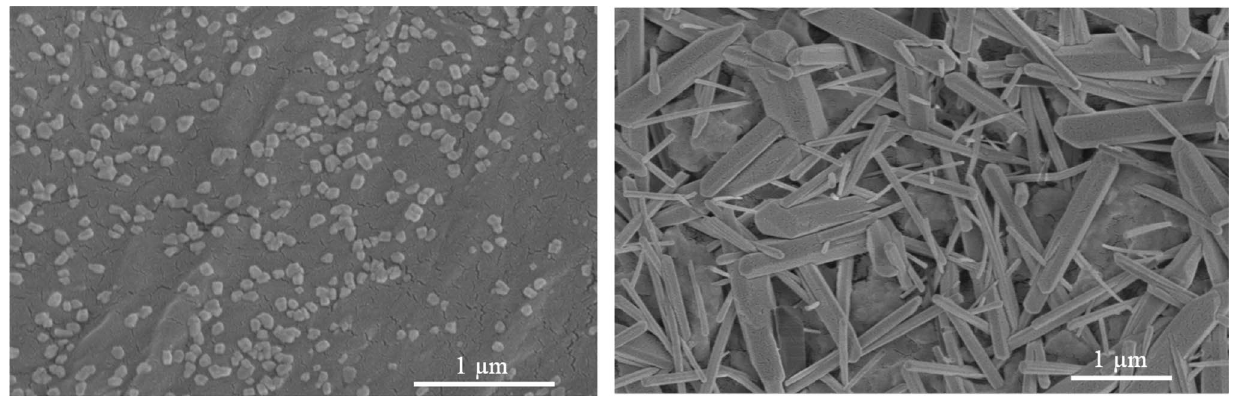
Fig. 5 SEM images of the acid-hydrolyzed water hyacinth (left) and the acid-hydrolyzed MFC (right)